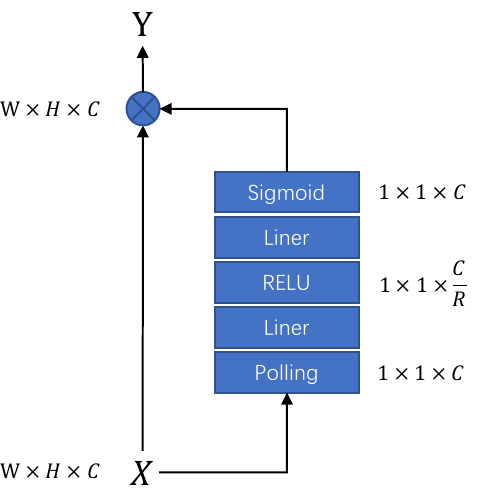
Figure 6. Channel attention